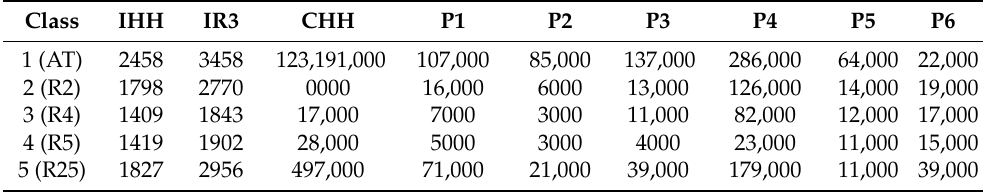
Table 3. Variables classification (1: RN1, AT, ES, R1,R6–R26 (24 roads); 2: R2, R3).